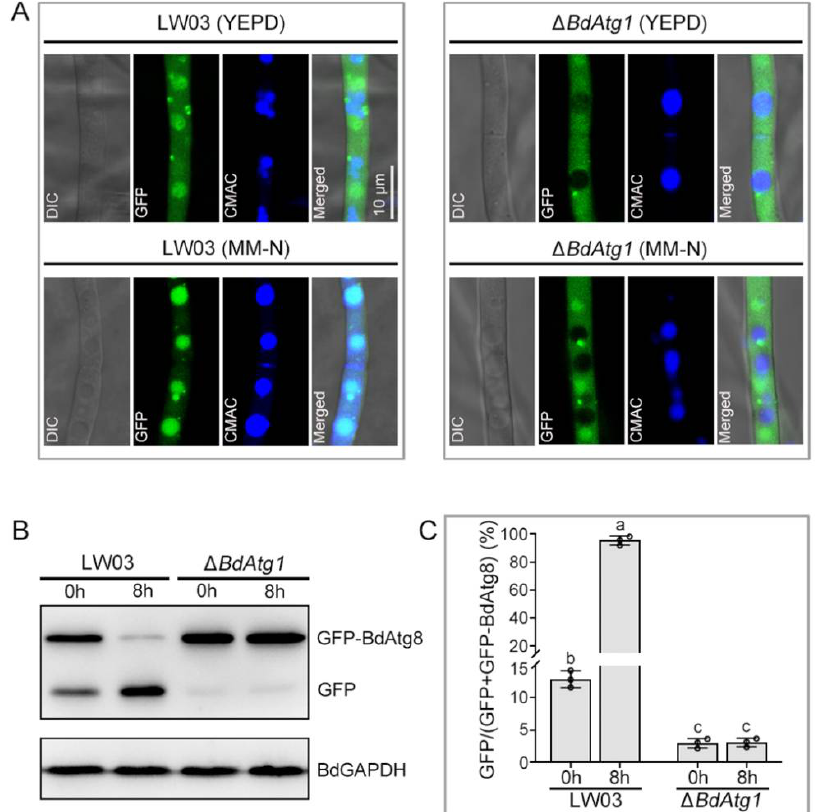
Figure 2. BdAtg1 is indispensable for autophagy. ( A ) GFP-BdAtg8 localization in the mycelia of the wild-type strain LW03 and BdATG1 deletion mutant Δ BdAtg1 under the conditions of sufficient or lack of nitrogen source. ( B ) GFP-BdAtg8 proteolysis of each strain (starvation for 0 and 8 h) was detected by Western blotting using anti-GFP antibody. GAPDH was used as an internal reference. ( C ) The percentage of GFP on the total of GFP and GFP-BdAtg8. Error bars indicate standard deviation from three independent experiments. Values on the bars followed by the same letter are not significantly different at p =